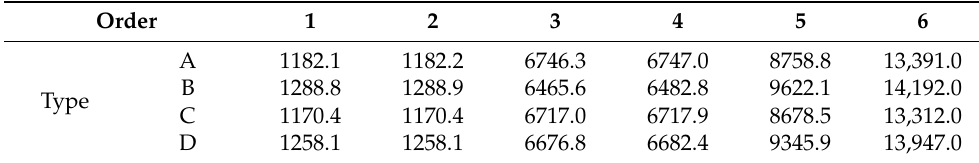
Table 3. First six-order natural frequencies (Hz) of each end milling